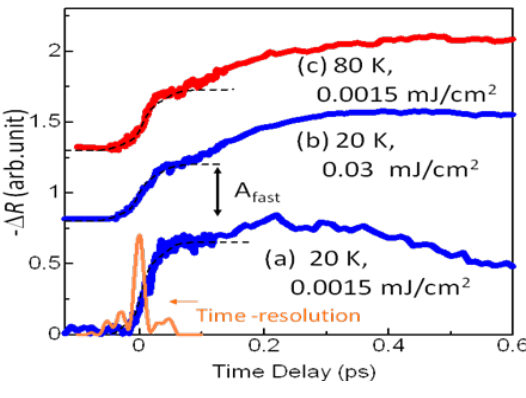
( b ) 0.03 mJ/cm 2 (blue curves) and at ( c ) 80 K (red curve: I response function G